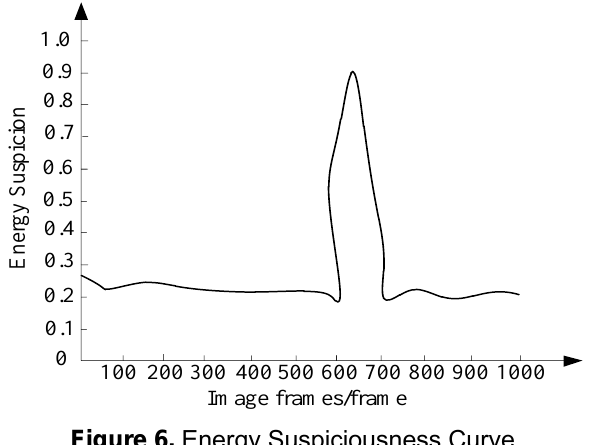
Figure 6. Energy Suspiciousness